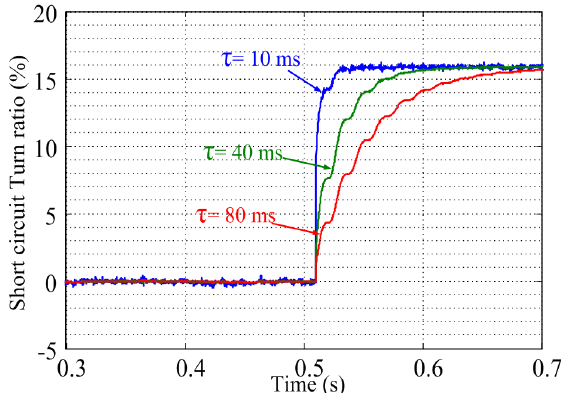
Figure 11. Estimation of 16% short circuit turn ratio in phase B in case of different τ .